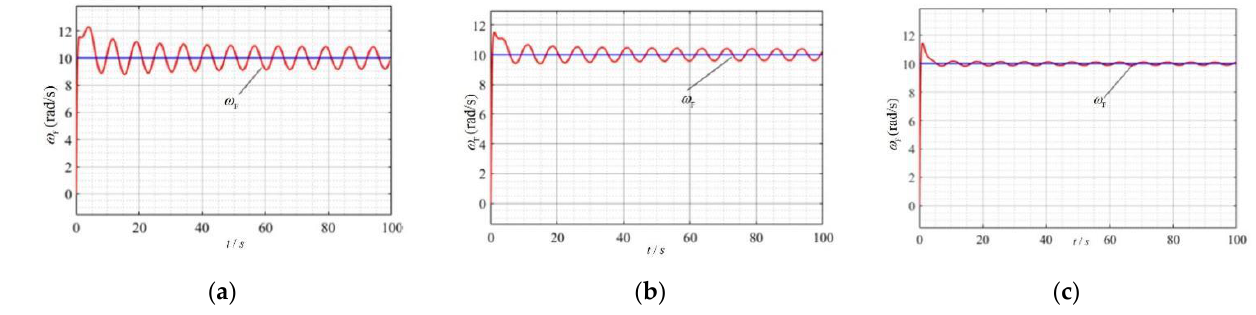
( b ) scheme (b). The blue line is the reference value line.